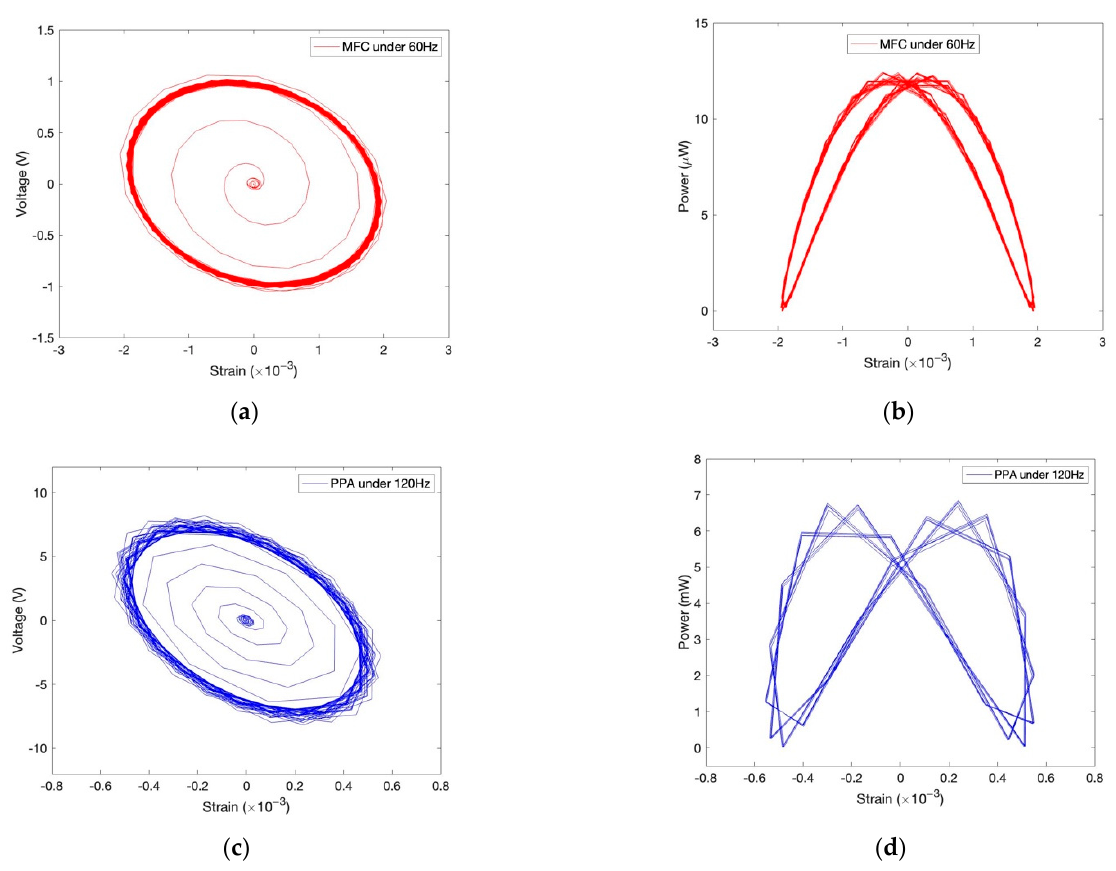
Figure 7. Electromechanical characteristics from MFC and PPA under resonant excitations. ( a ) Voltage vs. strain for MFC under 60 Hz; ( b ) Power vs. strain for MFC under 60 Hz; ( c ) Voltage vs. strain for PPA under 120 Hz; ( d ) Power vs. strain for PPA under 120 Hz.